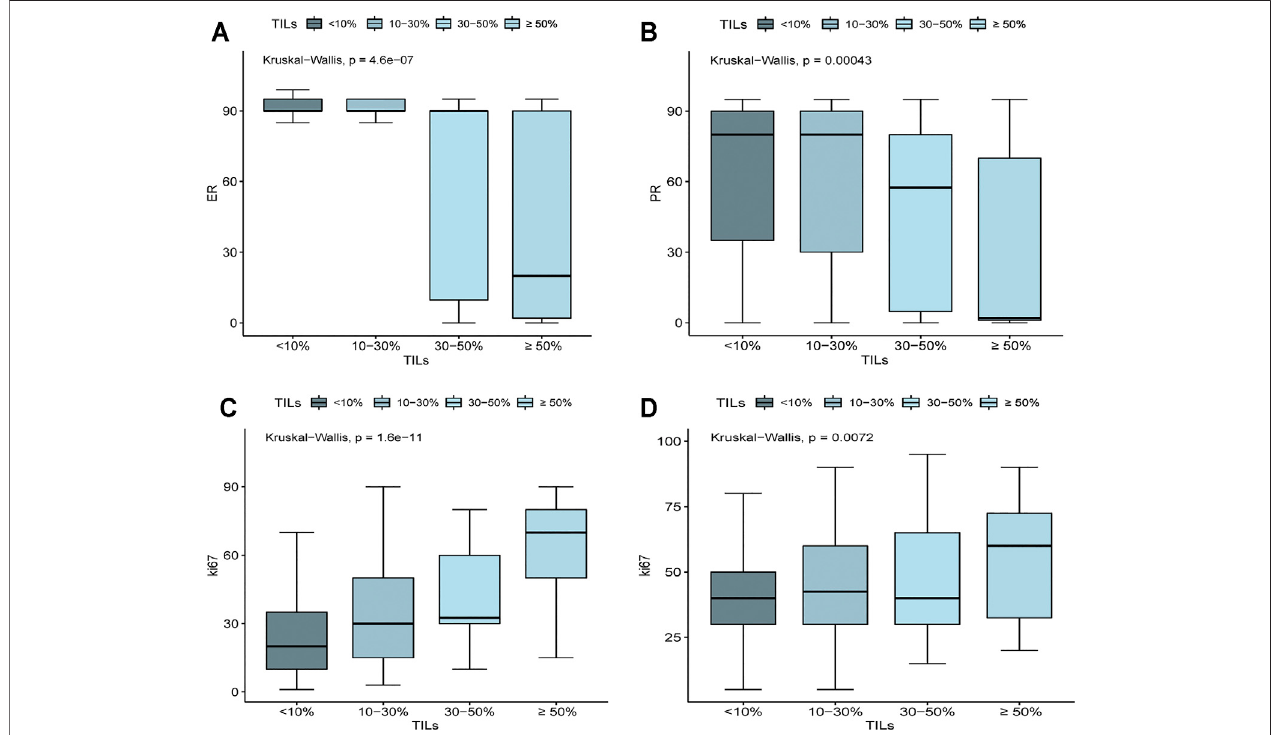
FIGURE2| AssociationsofER,PR,andKi67expressionlevelwiththedensityofTILs. (A) InHR+HER2 − BRCA,ERexpressionwasnegativelycorrelatedwithTILs ( p (cid:1) 4.6e-07). (B) In HR+ HER2 − BRCA, PR expression was negatively correlated with TILs ( p (cid:1) 0.00043). (C) In HR+ HER2 − BRCA, ki67 expression was positively correlated with TILs ( p (cid:1) 1.6e-11). (D) In TNBC and HER2+ BRCA, ki67 expression was positively correlated with TILs ( p (cid:1)